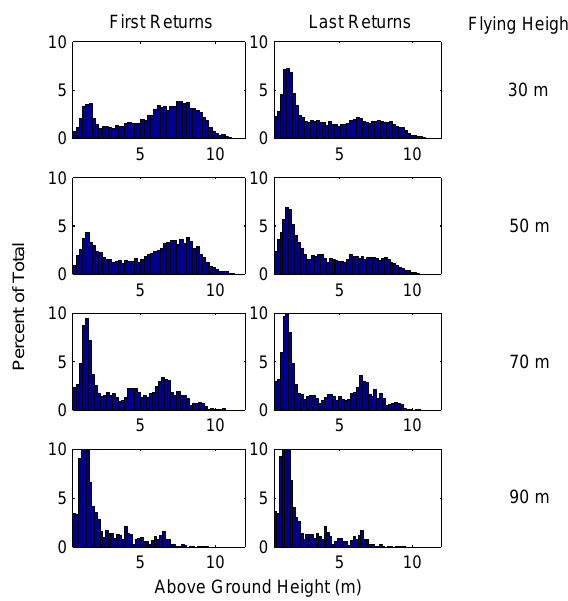
Figure 4. Histograms of the above ground height of vegetation returns over a single plot for point clouds captured at above ground flying heights of a) 30 m , b) 50 m , c) 70 m and d) 90 m . There is an obvious attenuation of upper canopy returns due to flight altitude. Figure 6. The effect of point density at the level of an individual tree. Showing a) full density point cloud at 30 m , b) full